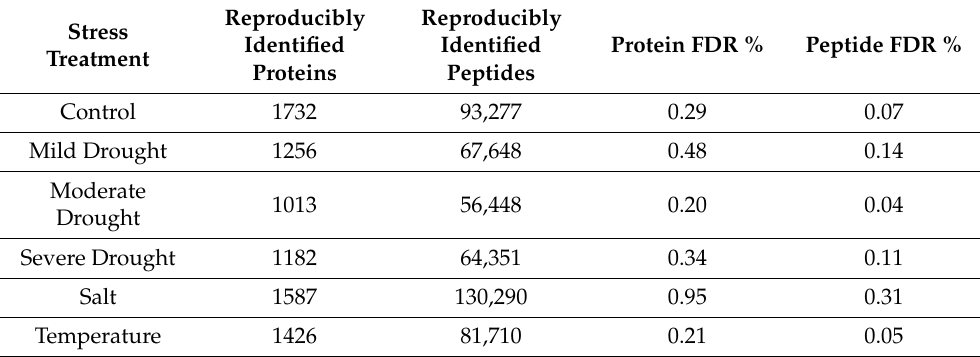
Table 1. Summary of the protein and peptide quantification data identified under individual abiotic stresses in Nipponbare (FDR = False Discovery Rate).